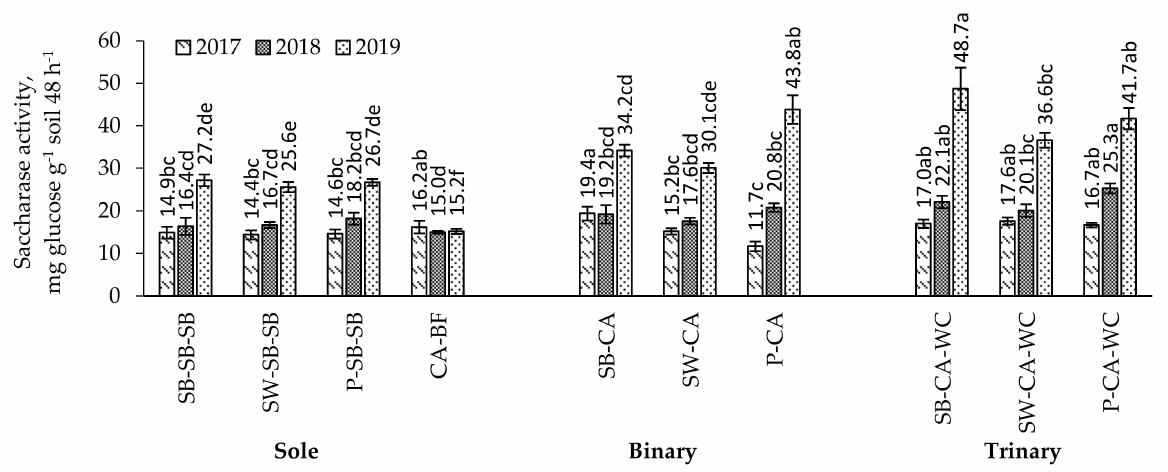
Figure 2. Saccharase activity in sole, binary, and trinary crops in 2017–2019. Note. CA—caraway; SB—spring barley; SW—spring wheat; P—pea; WC—white clover; BF—black fallow. Differences between the averages of treatments marked with different letters (a, b, c, d, e, f) are significant ( p < 0.05); error bars indicate the standard